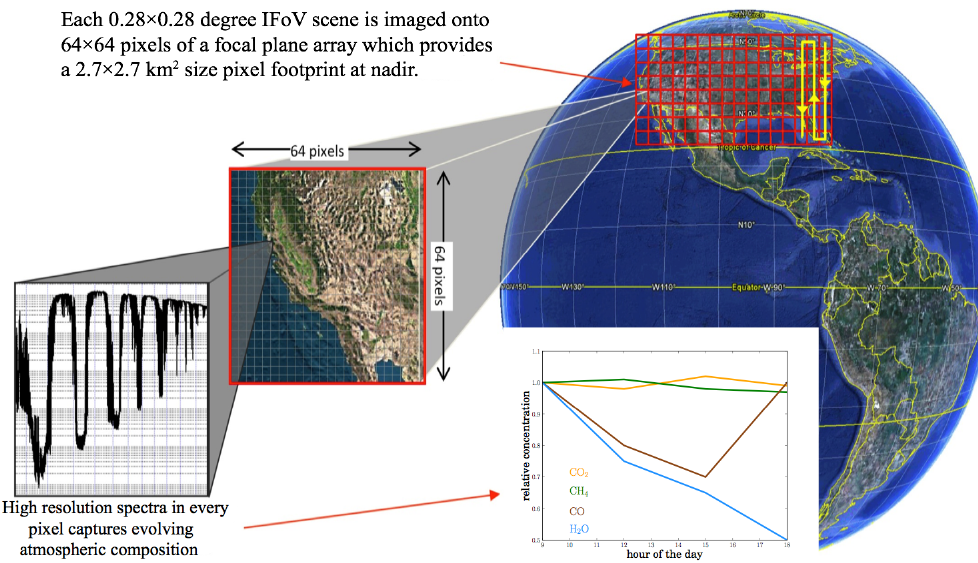
Figure 1. A schematic illustrating the GeoFTS observing system. Each 0.28 × 0.28 ◦ instantaneous field of view (IFoV) scene is imaged onto 64 × 64 pixels of a focal plane array, which provides a 2.7 × 2.7km 2 size pixel footprint at nadir. The evolving atmospheric compositions at different times of day (LT) are then inferred from the high-resolution spectra measured by the instrument. The relative concentrations of four target species with respect to those at 9a.m. are shown for illustration purposes